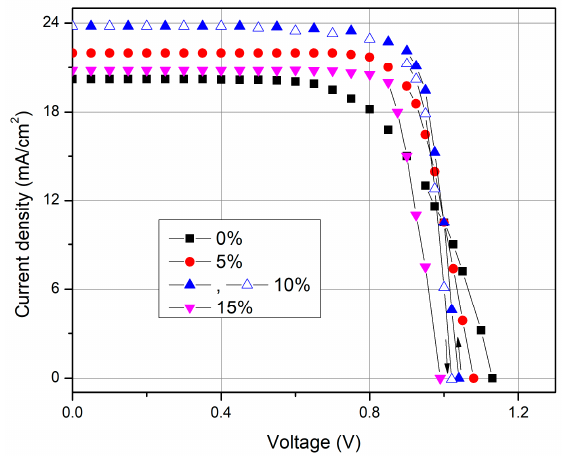
Figure 6. Current voltage characteristic of the perovskite solar cell with different cesium concen- trations.